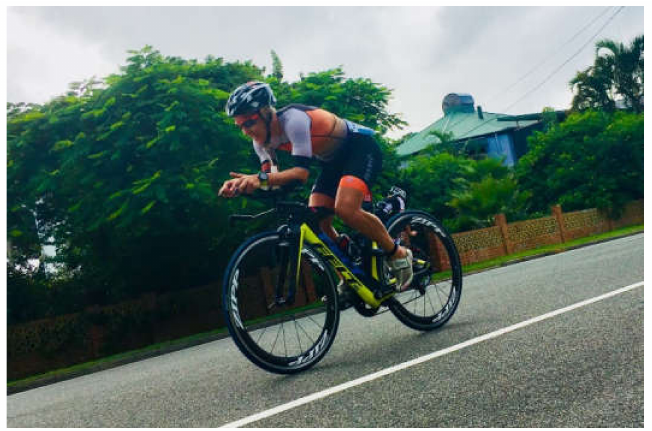
Figure 4. The 20 km bicycle stage of a long course sprint triathlon, Bribie Island, Queensland 25 March 2018. Cloudy conditions visible in the photograph on this day attenuate potentially very high exposures to the neck, arms and legs (see also Table